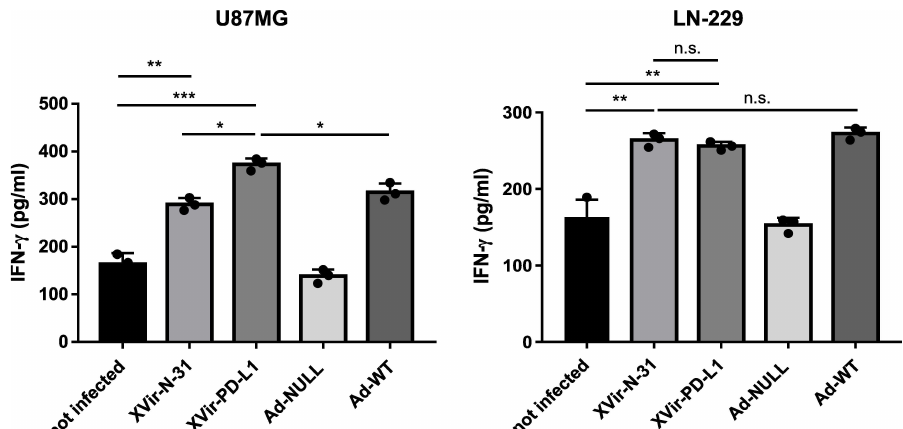
Figure 5. IFN- γ release from cocultures of HLA-matched human PBMCs with virus infected LN-229 or U87MG cells was measured by ELISA. The cells were infected with 30 MOI, were intensively washed with PBS 4 h later, collected 24 h p.i. and were then cocultured with HLA-matched PBMCs that had been treated with IL-2 (100 IU/mL, Immuno Tools, Friesoythe, Germany) 6 days before use. A total of 48 h later, the supernatants were collected and IFN- γ was measured by ELISA (XVir-PD-L1: XVir-N-31-anti-PD-L1; n = 3; SEM; n.s.: not significant; * p < 0.05, ** p < 0.01, *** p <